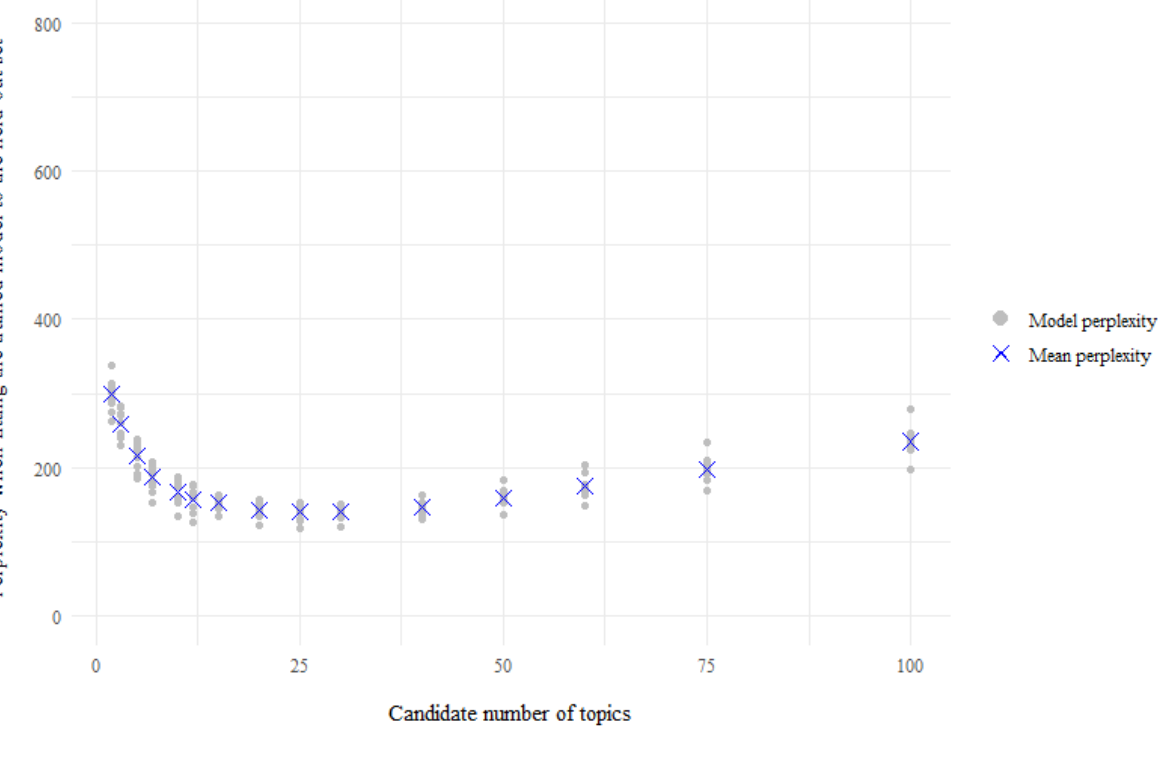
Figure 2. Perplexity scores for the models—LifeInfo health and fitness app question, 10-fold cross-validation of topic modelling to establish the optimal number of topics for latent Dirichlet